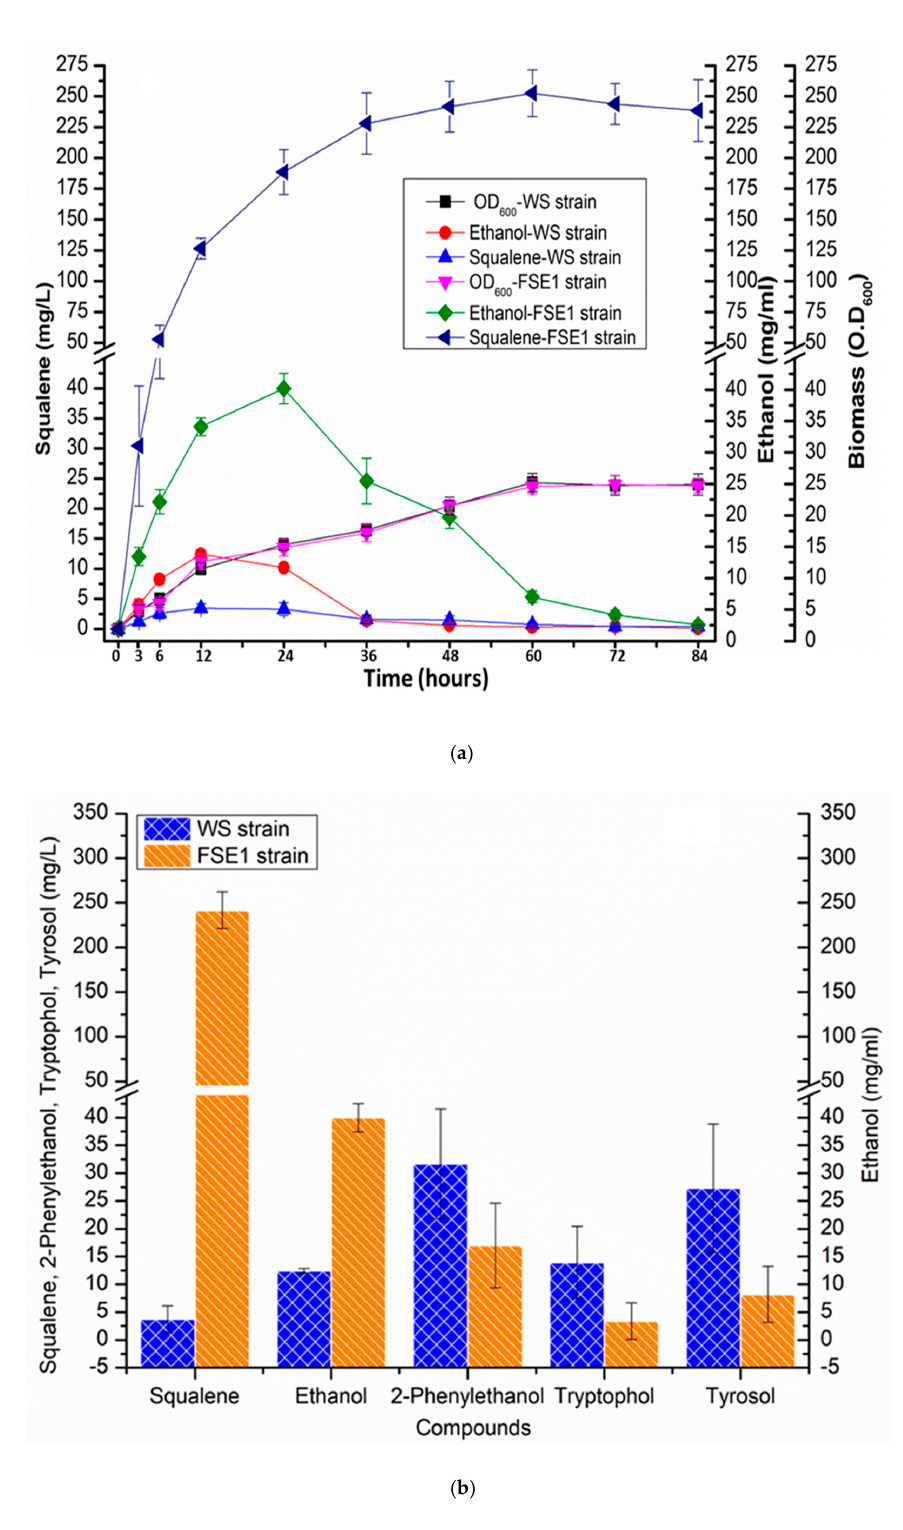
Figure 5. ( a ) Time course of squalene and ethanol co-production by FSE1 strain: Engineered FSE1 strain after co-expressing the squalene and ethanol pathways produced maximum titer of ethanol and squalene till 24th- and 60th hours respectively, of growth (b) Squalene and ethanol co-production in FSE1 strain caused the reduction of production of fusel alcohols including, 2-Phenylethanol, tyrosol, tryptophol compared to the WS. However, it also reduced the production of fusel alcohol including, 2-Phenylethanol, tryptophol, and tyrosol. It shows the self-diversion of metabolic flux by FSE1 in response to metabolic